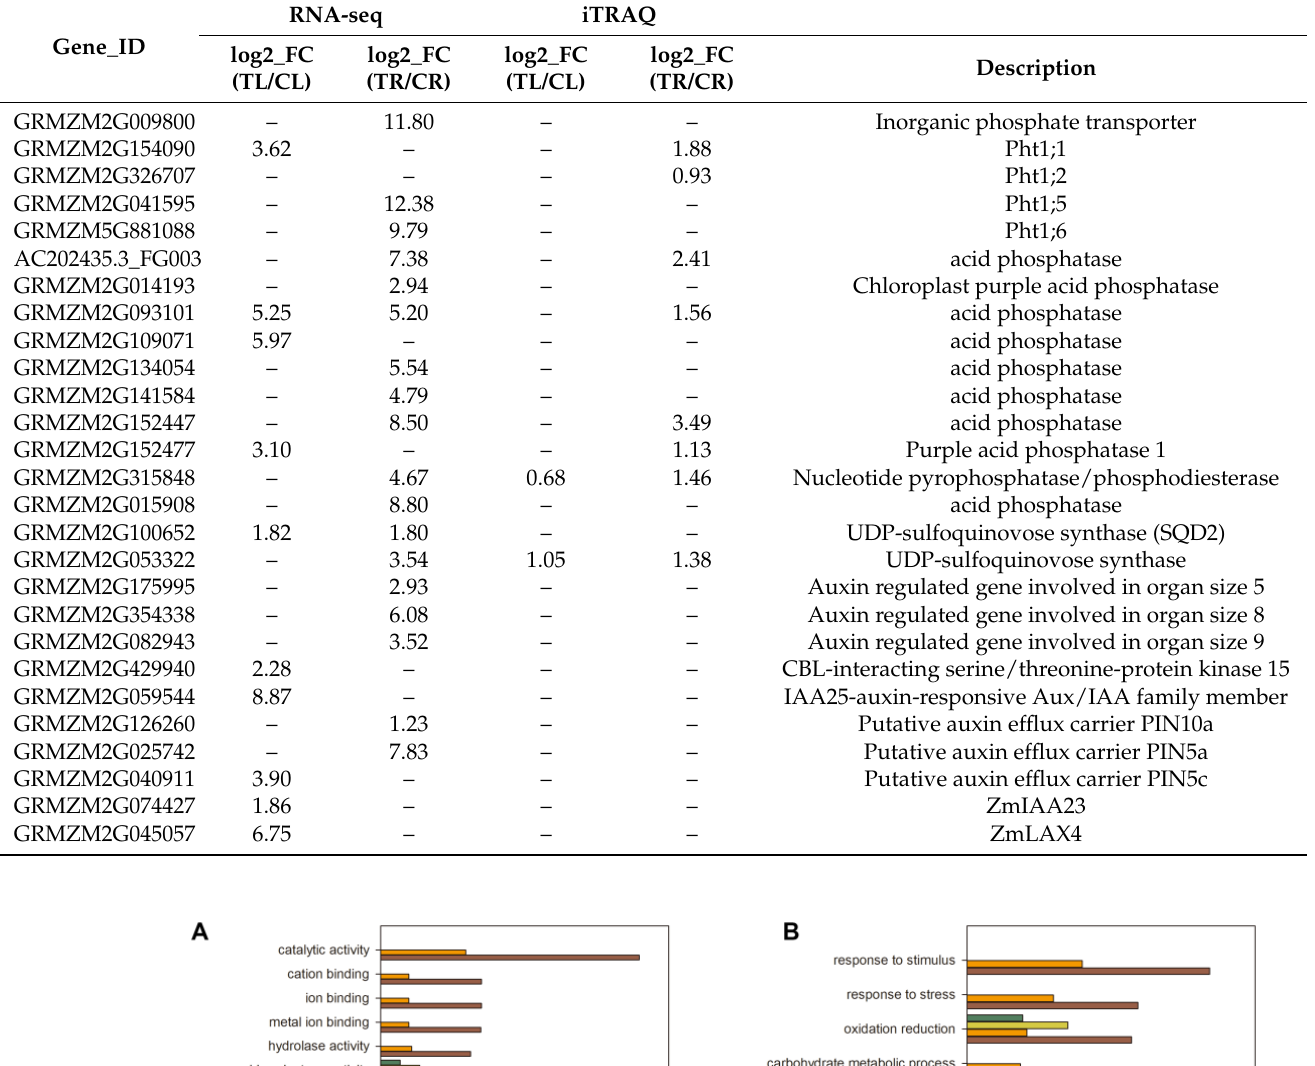
Table 1. Low-Pi induced genes.